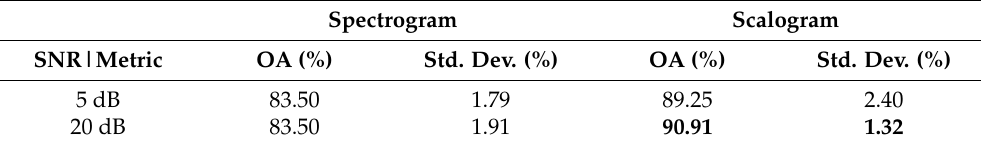
Table 11. The overall accuracy and standard deviation for classification of material type. The largest average overall accuracy (OA) and corresponding standard deviation (Std. Dev.) are denoted in bold.